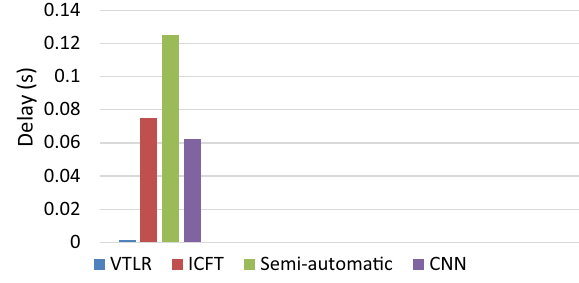
Figure 6. Average delay.